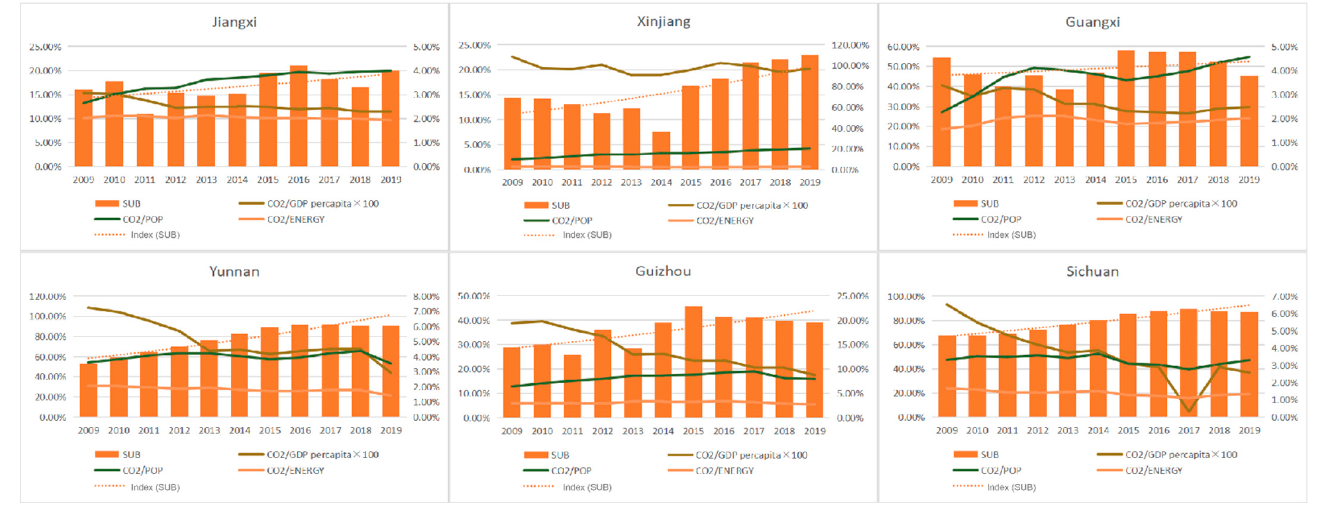
Figure 4. The Carbon Emission and SUB change across 30 provinces in China (2009–2019).